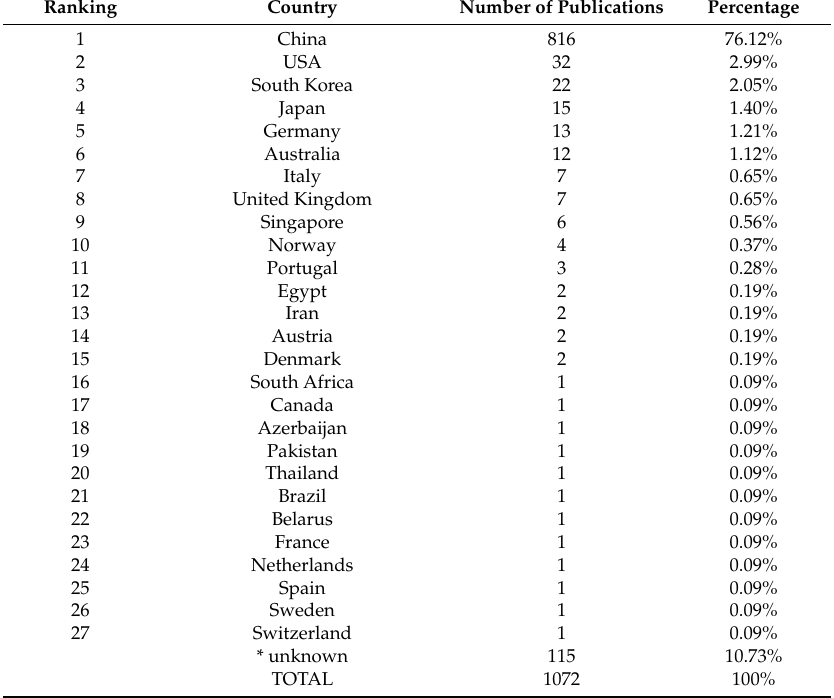
Table 1. Ranking of TCM scientific production by countries.